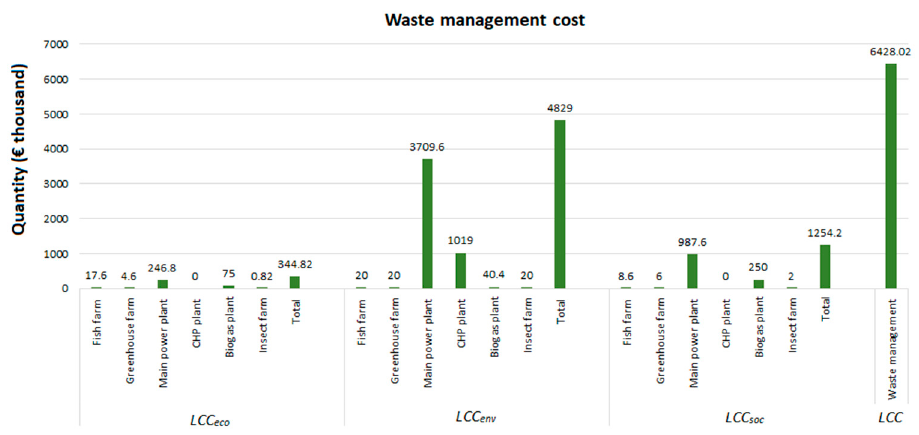
Figure 6. Life cycle cost of waste management in symbiotic environment in Sodankylä.